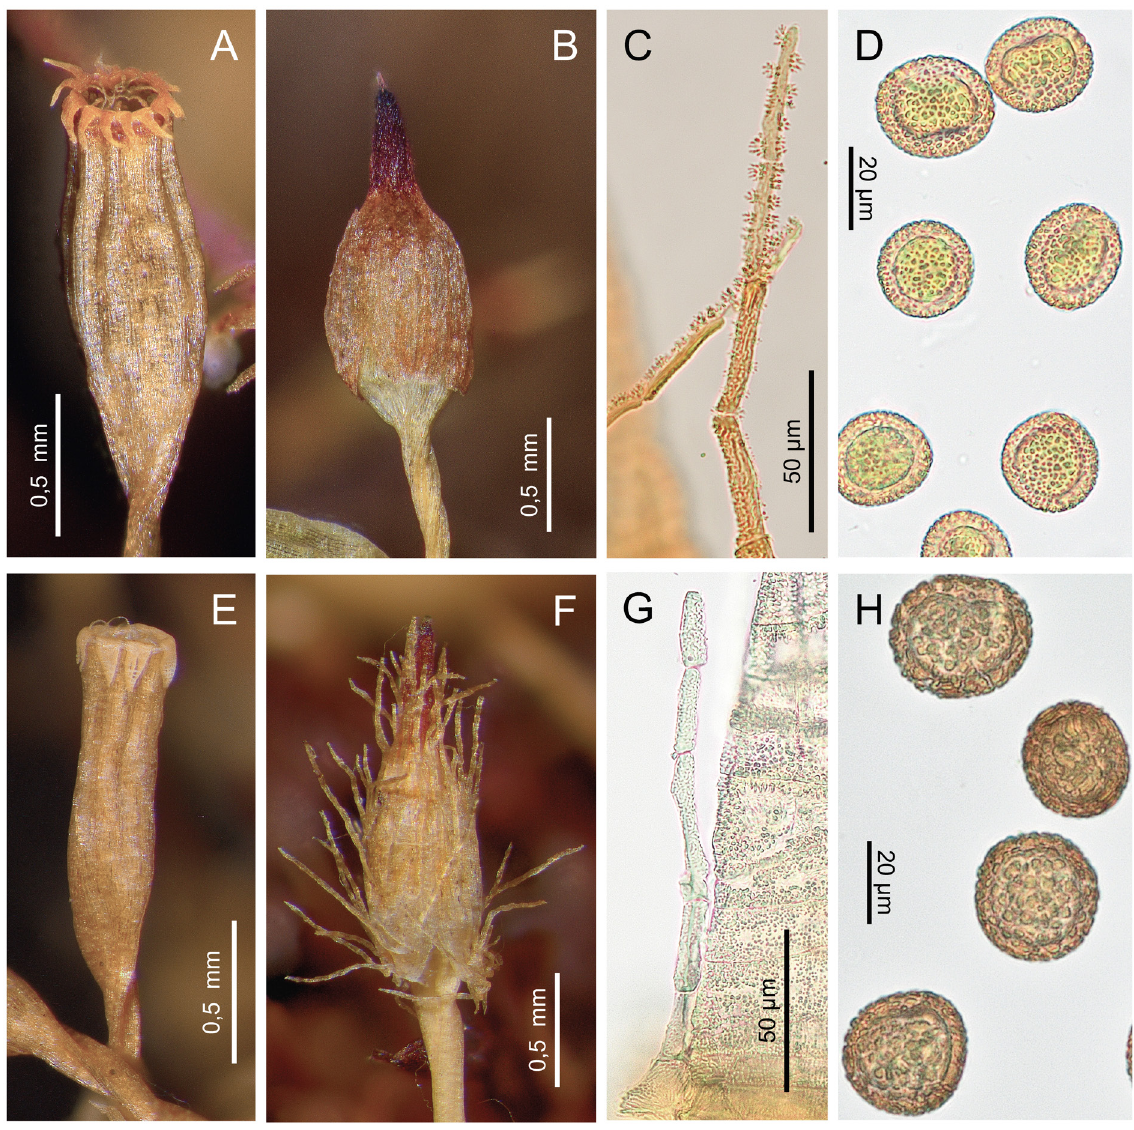
Fig. 4. Comparison between Ulota glabella Mitt. (A–D) and U. fuegiana Mitt. (E–H). A , E . Capsules, notice the difference in coloration and structure of exostome teeth. B , F . Calyptrae. C , G . Endostome ornamentation and coloration. D , H . Spore ornamentation. Each pair of images are at the